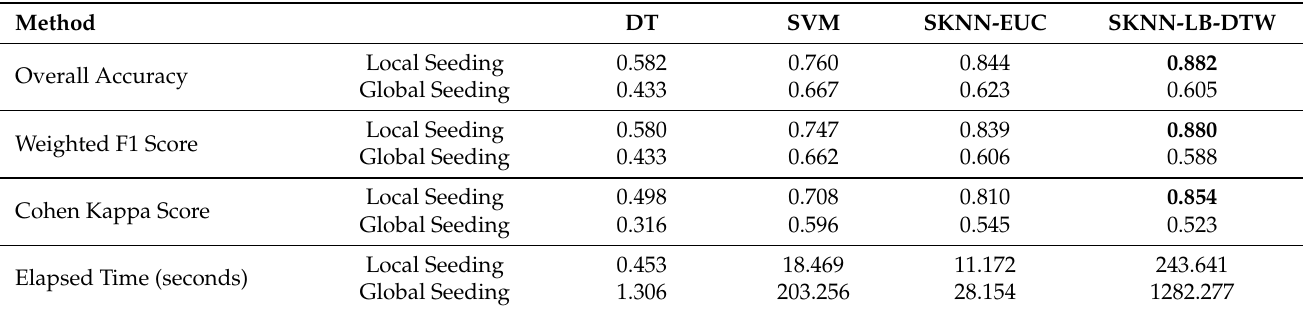
Table 1. Statistical comparison of the classification performance for the first